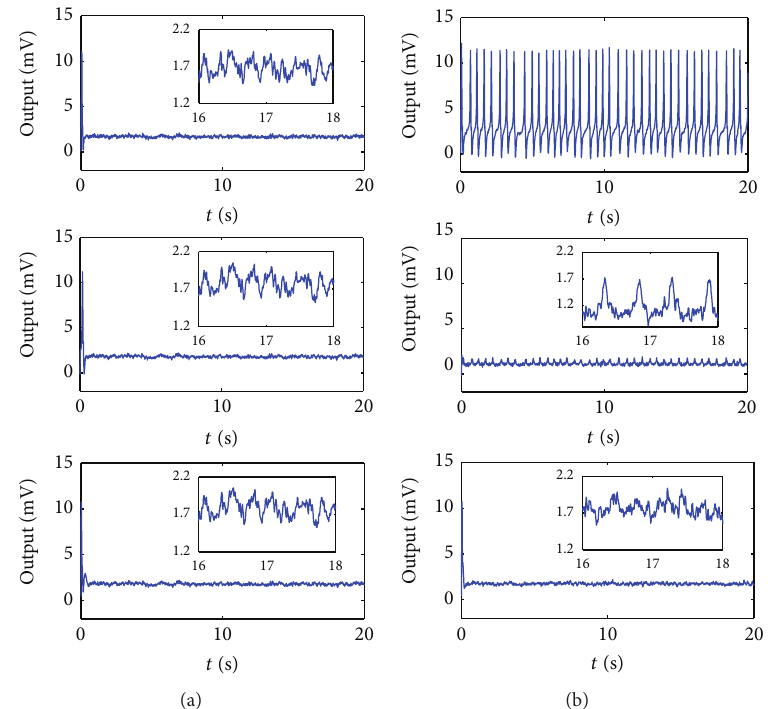
Figure 6: The output waveforms for the use of the proposed control to the model containing one hyperexcitable population. (a) 𝑘 𝑝1 = 1.96 , = 𝑘 = 0 . (b) 𝑘 = 6 , 𝑘 = 𝑘 = 0 . 𝑘 𝑝2 𝑝3 𝑝2 𝑝1 𝑝3